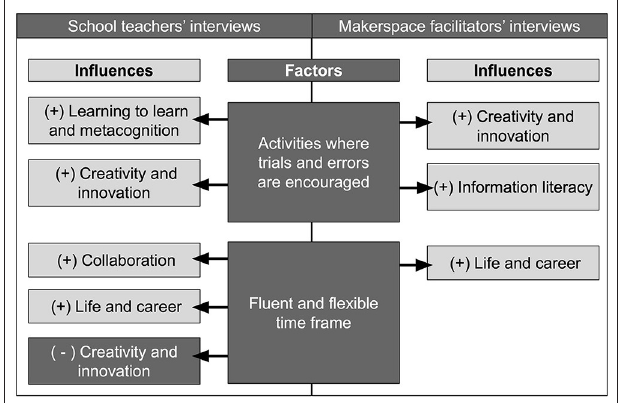
FIGURE 3 | The factors regarding learning environment and the structure of the activities and their positive influence ( + ) and negative influence ( − ) on learning 21st century skills and CT